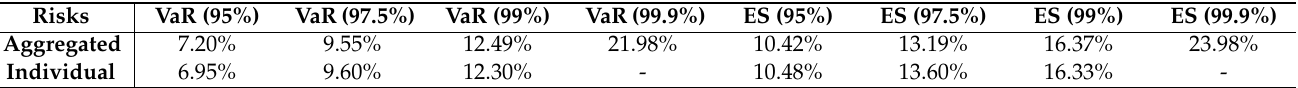
Table 11. Value-at-Risk and Expected-Shortfall of the